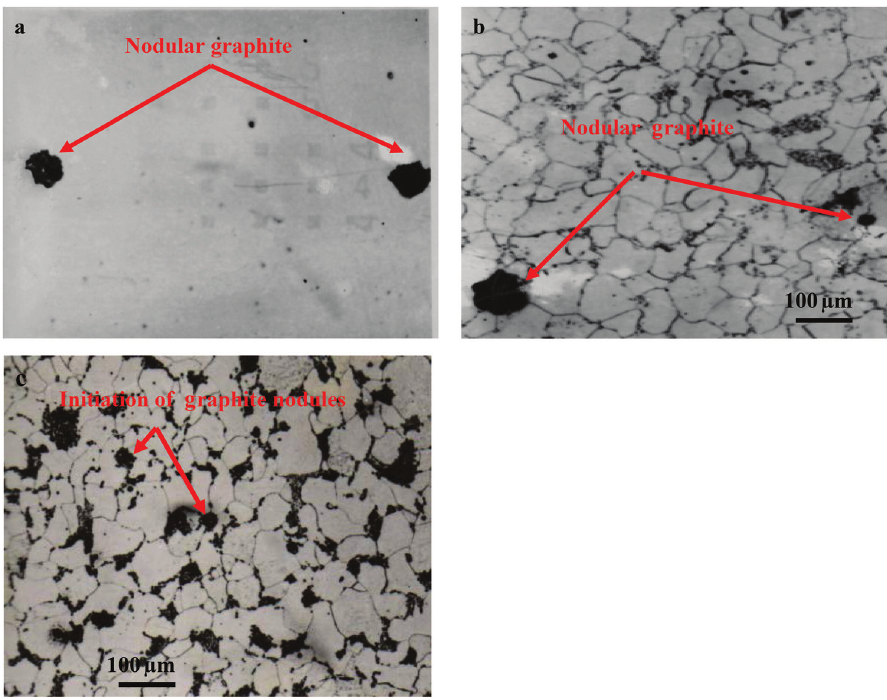
Figure 4: Microstructure showing (a) graphite nodules at unetched matrix at failure region; (b) complete breakdown of pearlite resulting in growth of graphite nodules at etched condition at failure region and (c) breakdown of pearlite and initiation and growth of graphite nodules at away from the failure zone.